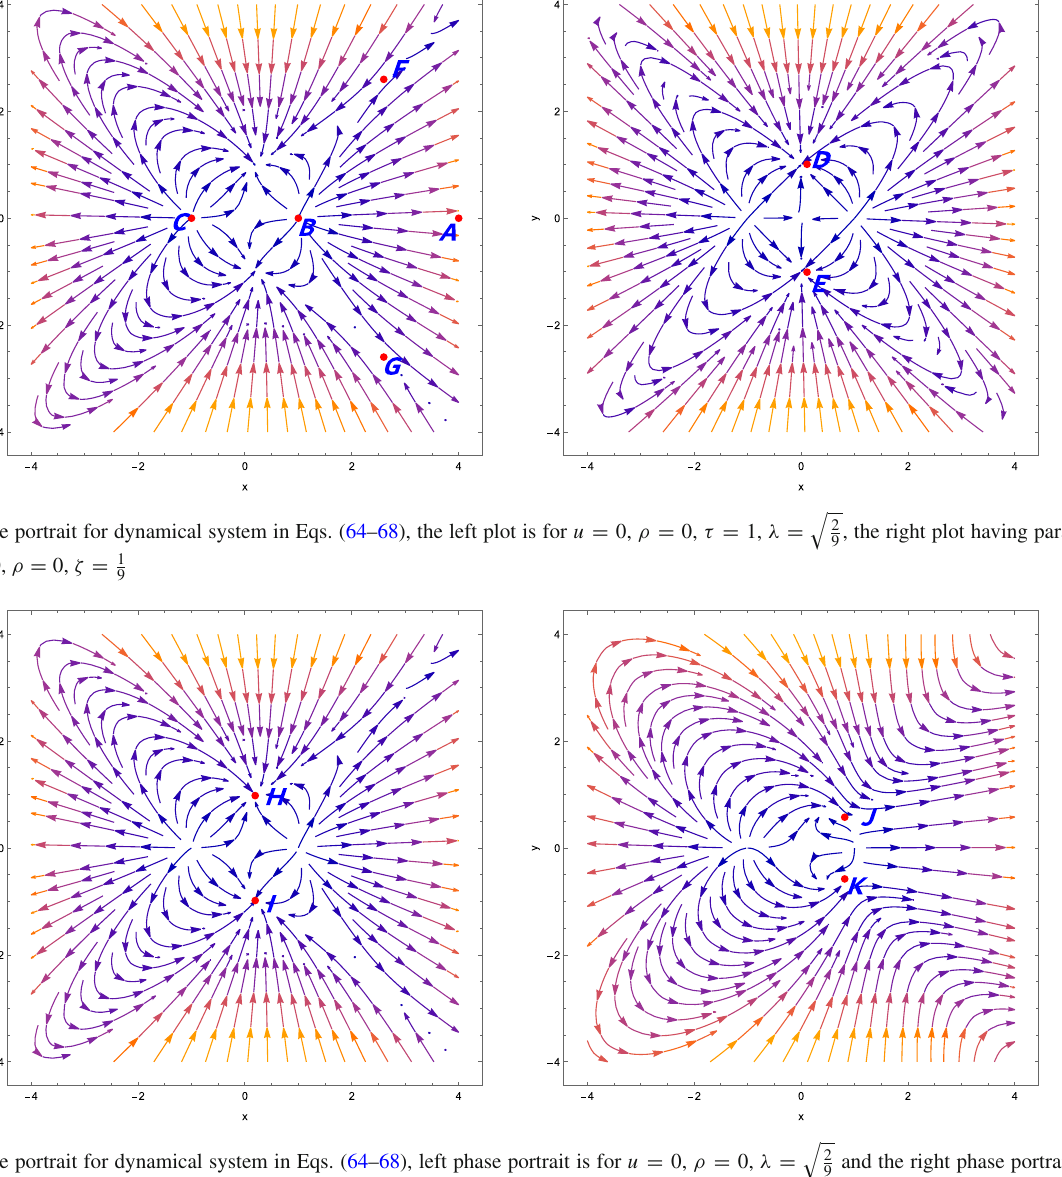
Fig. 4 Phase portrait for dynamical system in Eqs. (64–68), left phase portrait is for u = 0, ρ = 0, λ = u = 0, ρ = 0